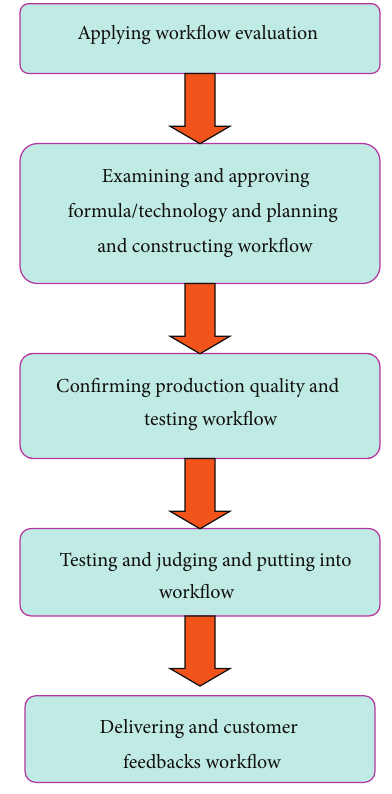
Figure 1: Entire flow chart of new composite materials